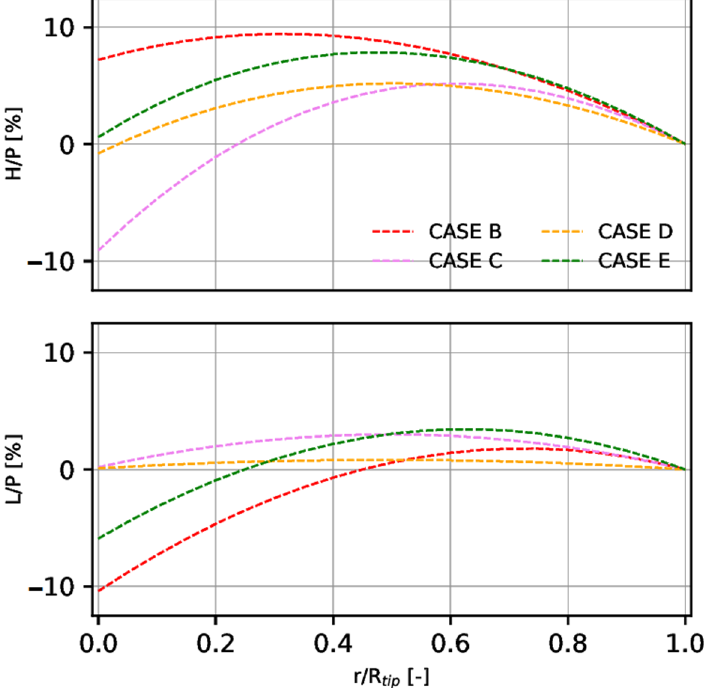
Figure 10. Distribution of the geometric FEC coefficient for the high-pressure ( top ) and low-pressure ( bottom ) cap of the cases: B, C, D and E.